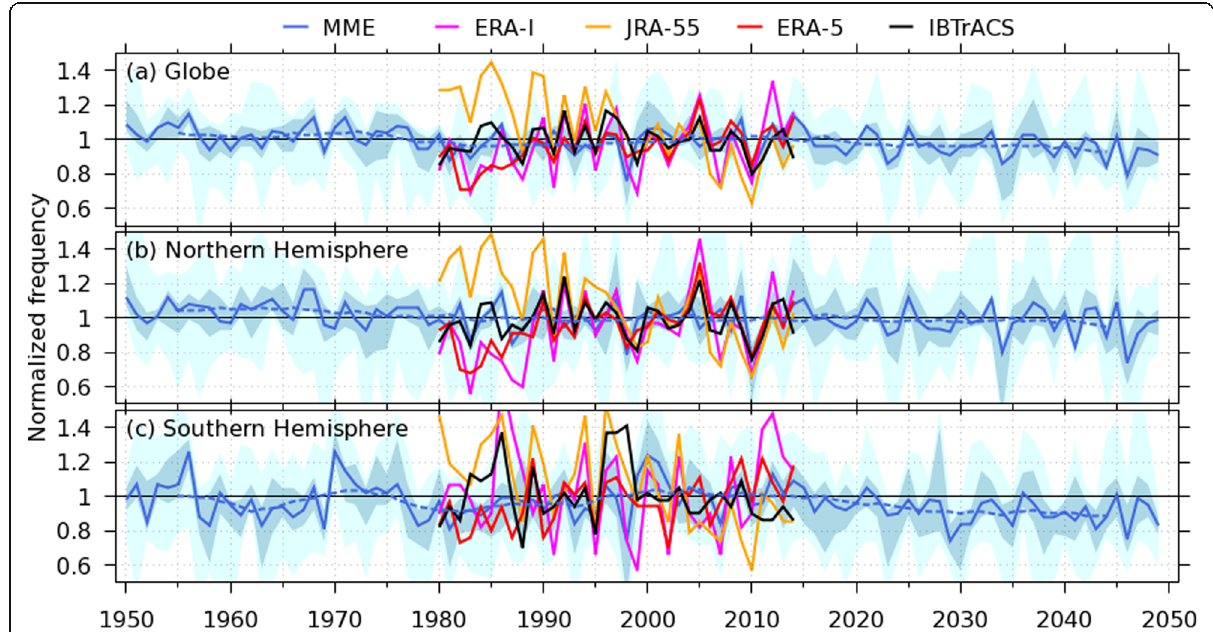
Fig. 2 Time series of normalized annual TC genesis frequency. Annual TC genesis frequency was normalized based on the mean value from 1990 to 2014 for respective data. Panels show time series of normalized annual TC genesis frequency for a the globe, b the Northern Hemisphere, and c the Southern Hemisphere, respectively. Black solid line indicates IBTrACS. Blue solid line shows the median value of models without NCM014. Blue dotted line shows eleven years running mean of the median value of the models. Light blue colored area indicates a range between 5 and 95 percentile values of the models. Deep blue colored area indicates a range between 25 and 75 percentile values of the models. Magenta line is a result from ERA-I. Orange line indicates JRA-55. Red line indicates ERA-5